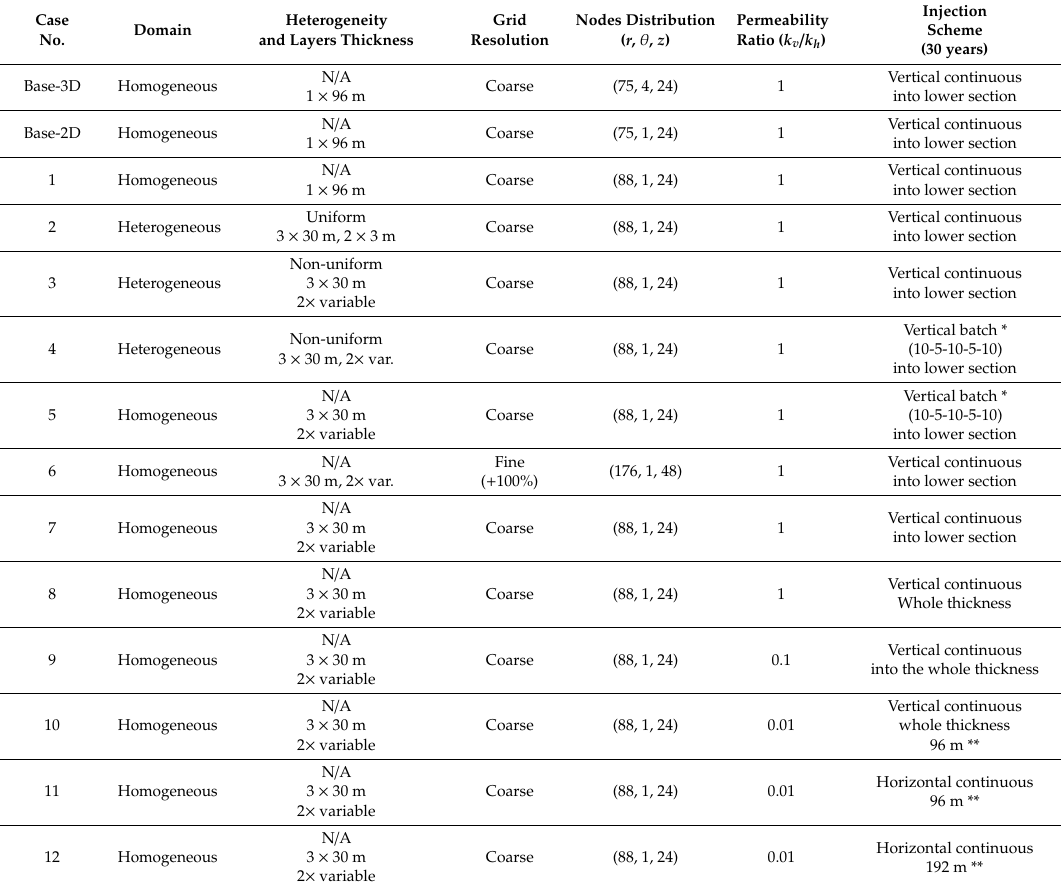
Table 3. Simulation cases and